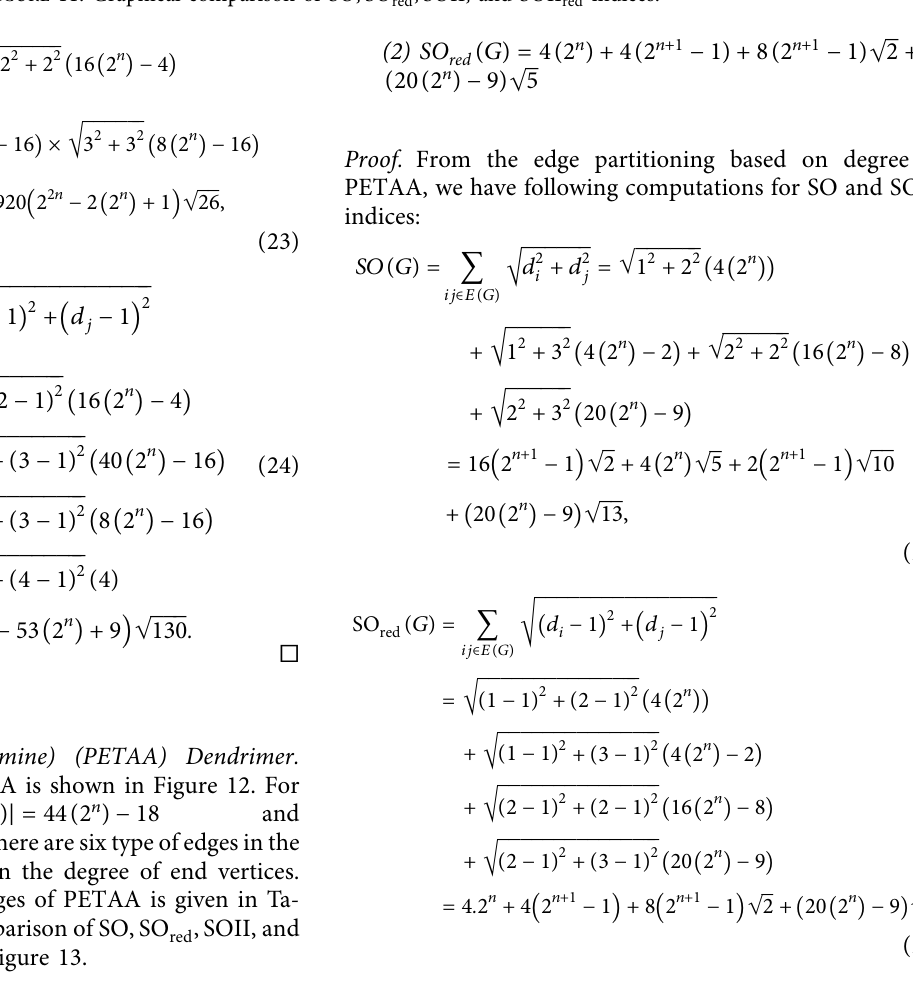
, SOII, and SOII red red